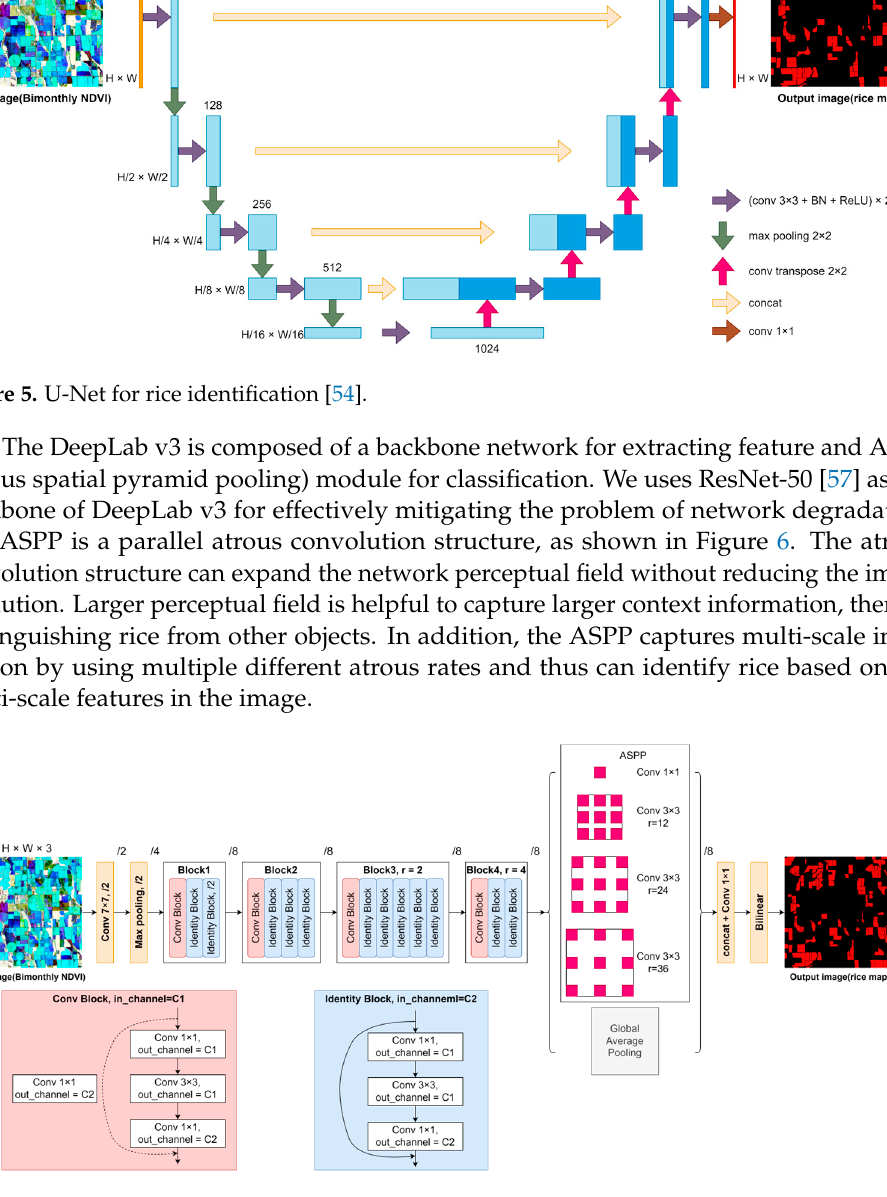
Figure 6. DeepLab v3 (backbone is ResNet50) for rice identification [55].